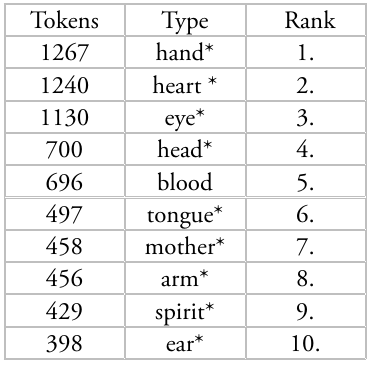
Table 2: Frequency ranking in the Shakesperean corpus (from List B).